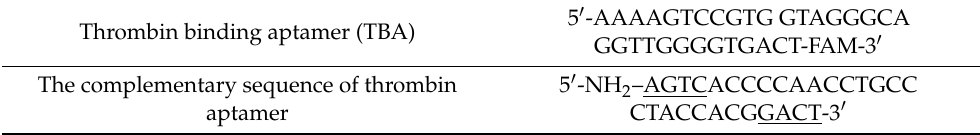
Table 1. DNA sequences for this experiment. Thrombin binding aptamer (TBA) The complementary sequence of